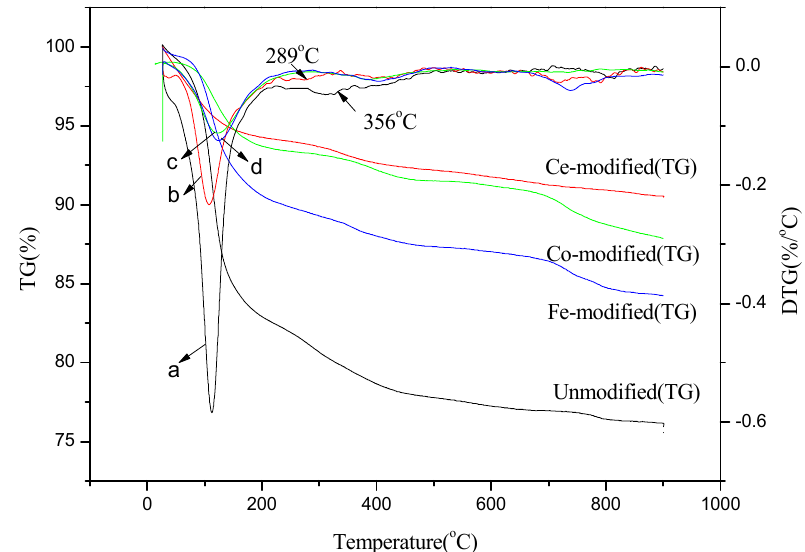
Figure 5. Thermal gravity analysis (TG)-differential thermal gravity (DTG) diagram of catalyst SO 2 poisoning after addition of different transition metal additives ( a : Unmodified, b : Ce-modified, c : Co-modified, d : Fe-modified).